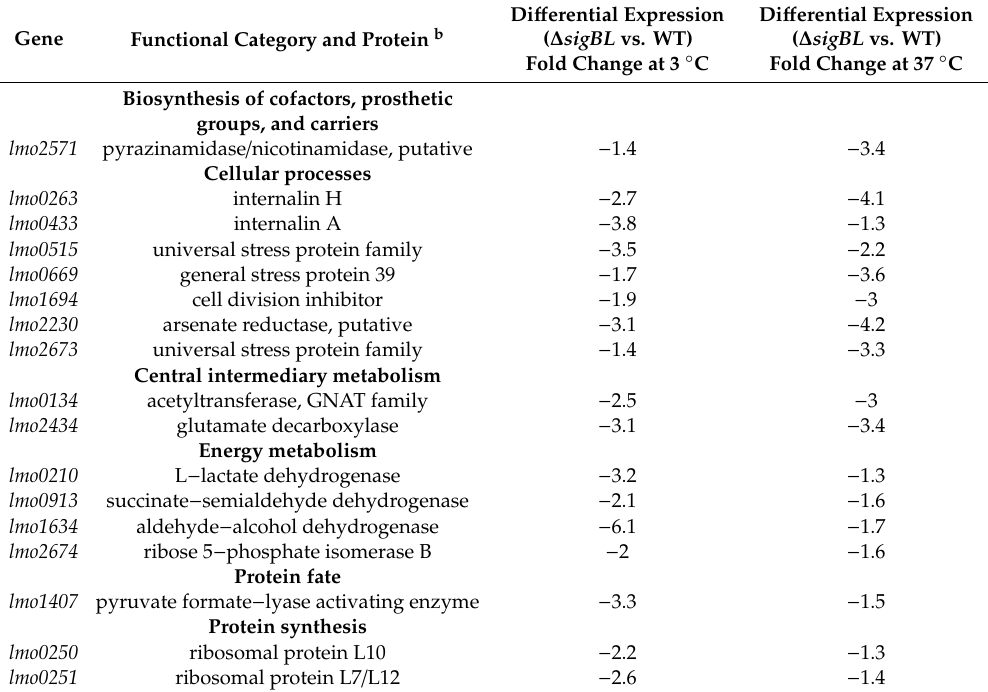
Table 4. Genes that were down − regulated during exponential growth of Listeria monocytogenes ∆ sigBL in BHI at 3 and 37 ◦ C a